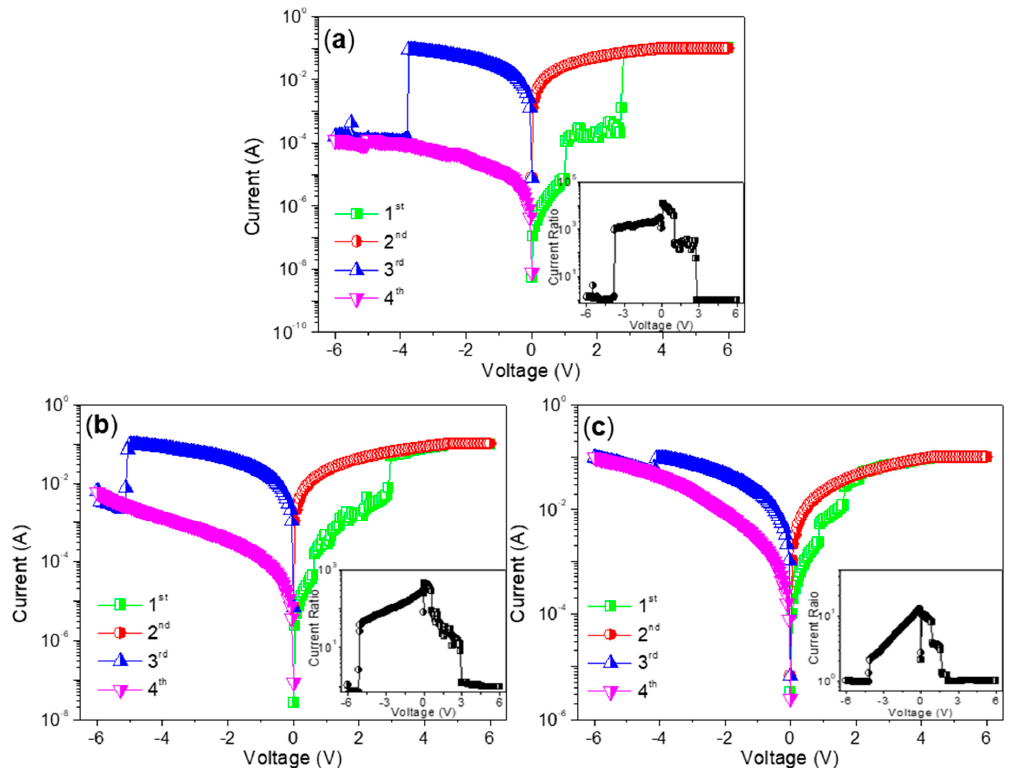
Figure 8. I – V characteristics of the multi-bit biomemory behaviors for ITO / CS:GO / Ni concerning distinct chemical component ratio of CS:GO naoncomposite ( a ) 2:1, ( b ) 5:1, and ( c ) 10:1 ( w / w ), respectively. Inset: the current ratio dependent on the applied bias.